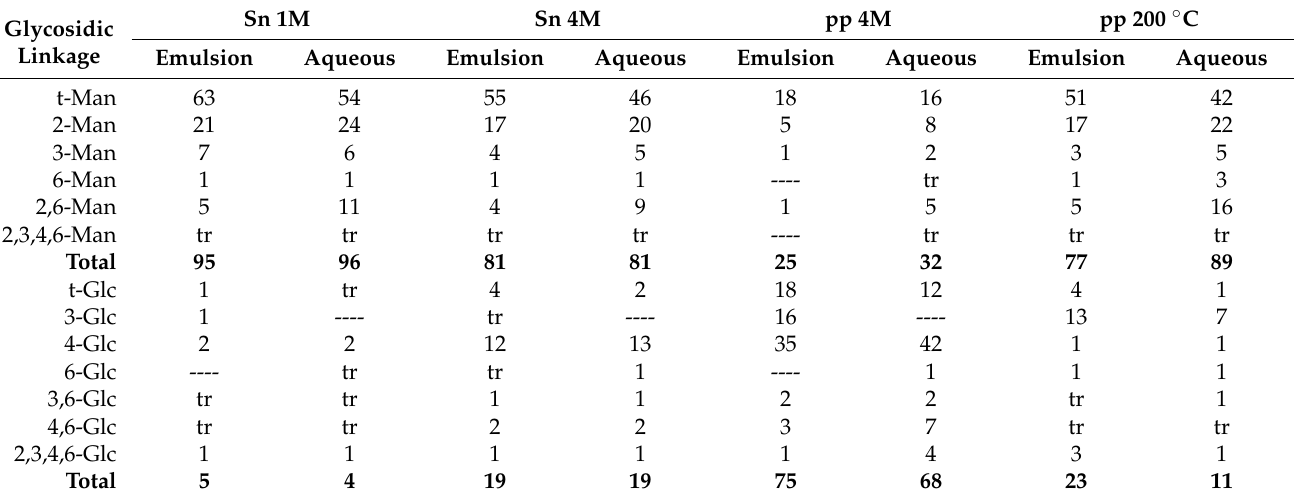
Table 5. Glycosidic linkage composition (molar %) of brewer’s spent yeast extract’s emulsions (ultraturrax) from the material partitioned after phase separation, after 1-month